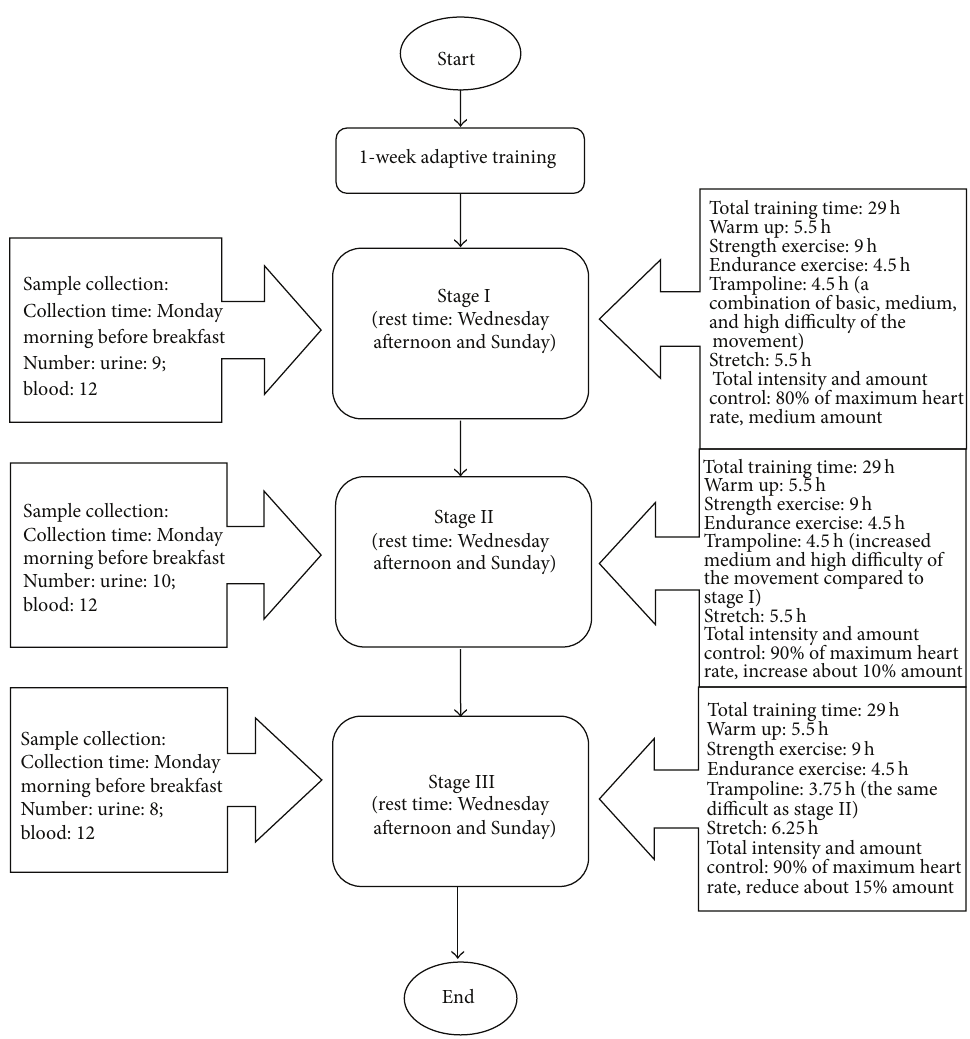
Figure 1: The flowchart for illustration of three-stage/level training